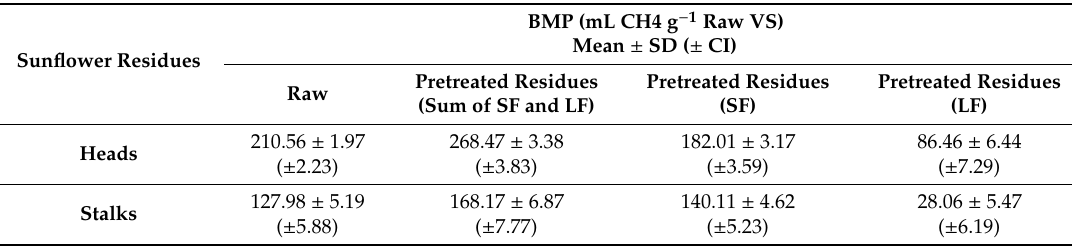
Figure 1. Biochemical methane potential (BMP) profiles of pretreated and untreated sunflower ( a ) heads and ( b ) stalks. Values correspond to means of triplicates of independent values ± standard deviations (error bars). SF: solid fraction, LF: liquid fraction. Table 4. Biochemical methane potential (BMP) of raw and pretreated sunflower residues. SF: solid fraction, LF: liquid fraction.